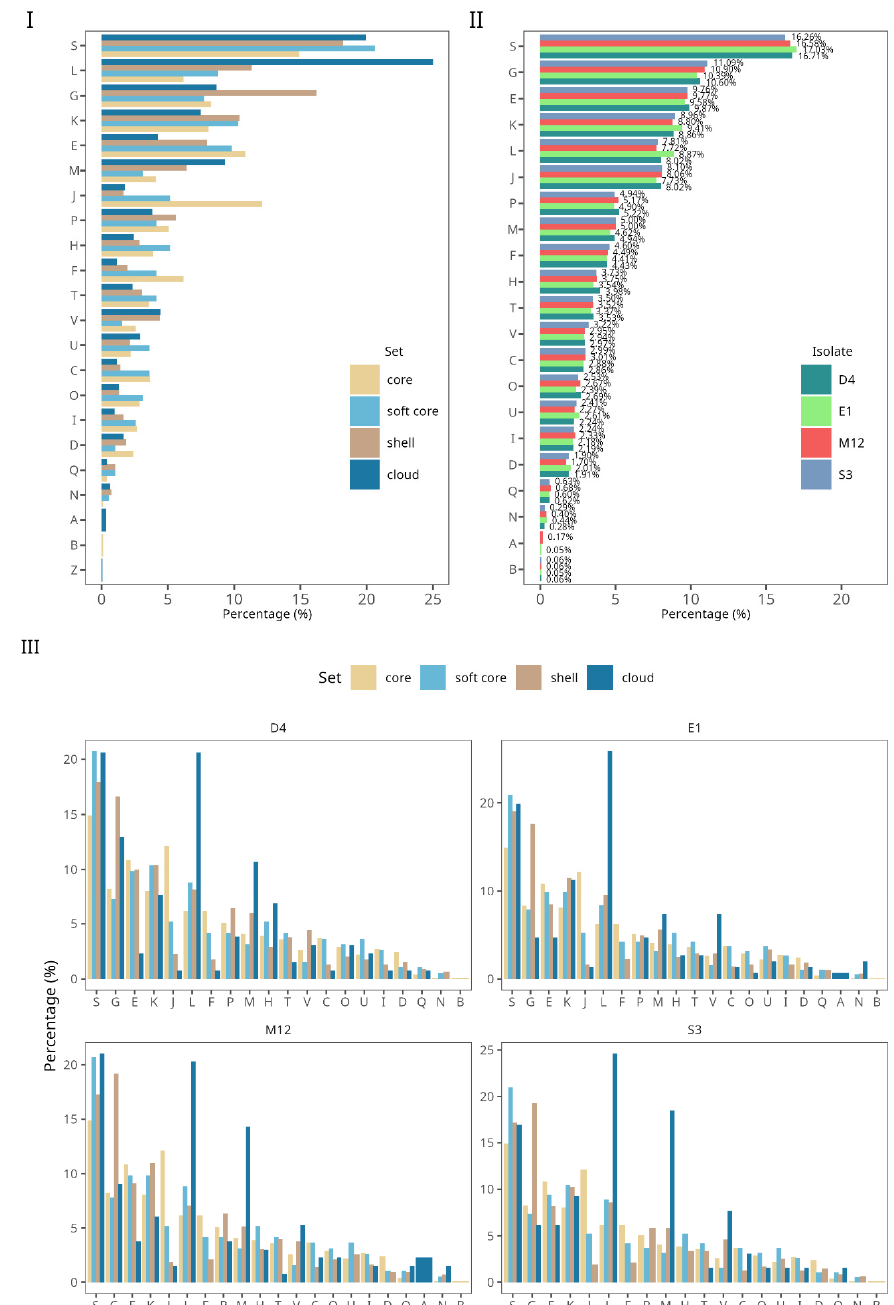
Figure 3. Pangenome of B. longum subsp. longum strains. ( A ) Pie chart indicating the gene set in the pangenome. ( B ) Plot of the accumulate number of new genes against the number of genomes added in the pangenome. ( C ) Number of genes attributed to the core genome versus the number of genomes added in the core genome plot.